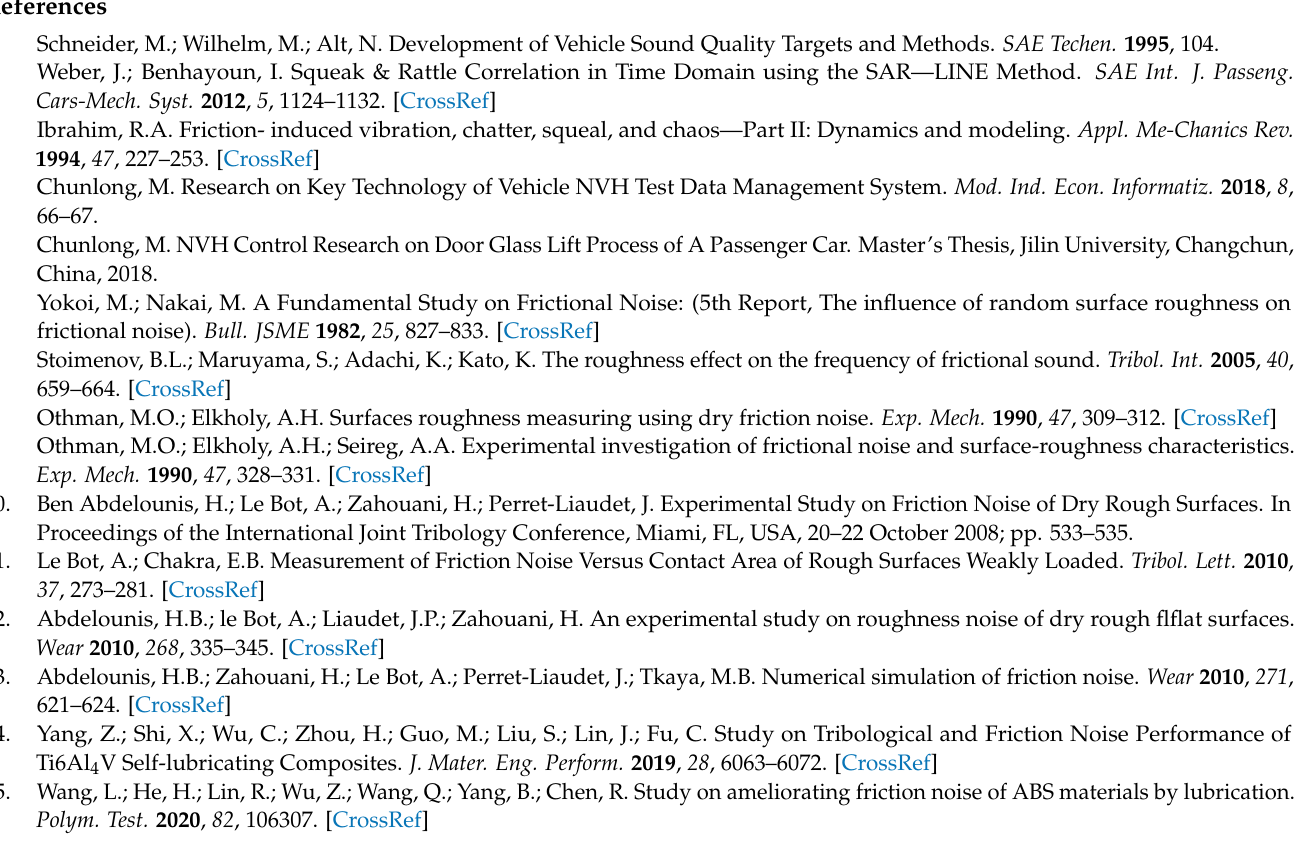
Figure A1. The optimized cross-section of the inner belt of the automobile door.